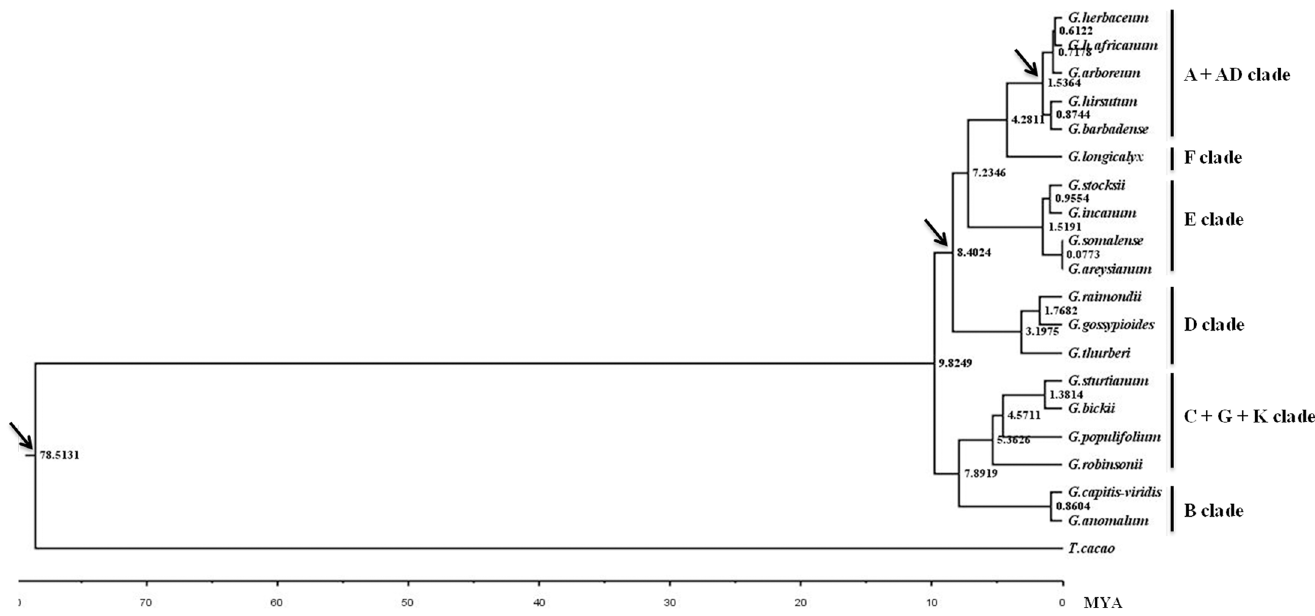
Fig 5. Chronogram showing Gossypium phylogeny and divergence time with T . cacao as an outgroup. Consensus tree presenting divergence dates produces by the PhyloBayes analysis of the 78 concatenated chloroplast protein-coding exons dataset using three fossil calibration points (S8 Table), the autocorrelated Lognormal relaxed-clock mode, the site-heterogeneous mixture CAT+GTR substitution model, and soft bound 10%. A geological time scale is shown at the bottom. The arrows represent for three calibration points.